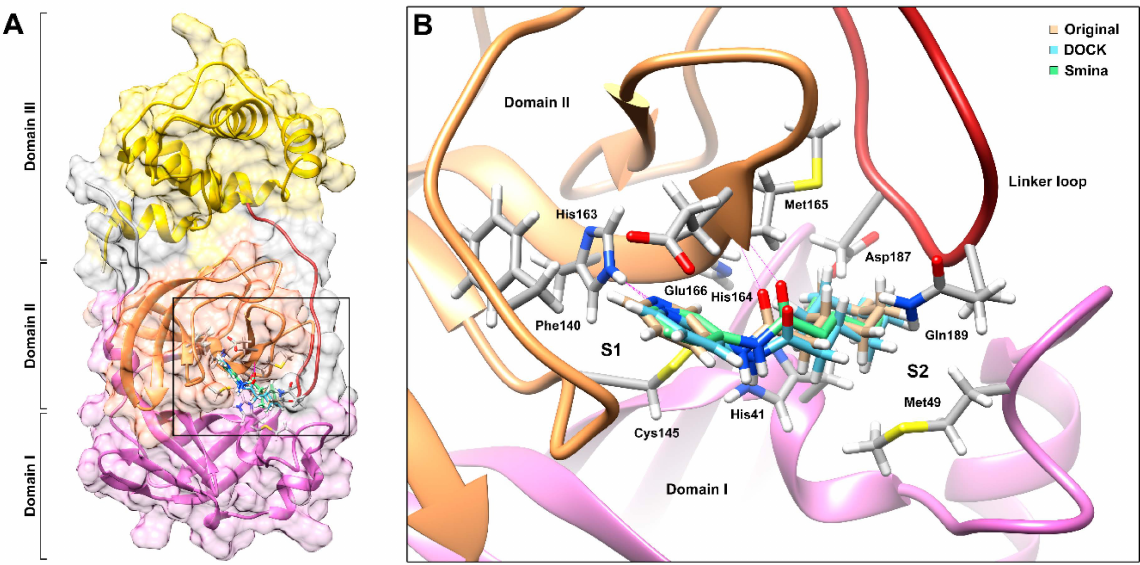
Figure 1. Redocking of the ligand co-crystalized with chain A of SARS-CoV-2 main protease (M pro ) in Protein Data Bank (PDB) 5R84. ( A ) Location of the active site relative to the domains I, II and III of M pro , respectively, colored purple, orange and yellow. Linker loop connecting domains II and III is colored dark red. ( B ) Comparison of docking poses obtained with DOCK and Smina (flexible docking approach) with the original orientation of the co-crystalized ligand. Hydrogen bonds with residues His163 and Glu166 are represented with thin purple